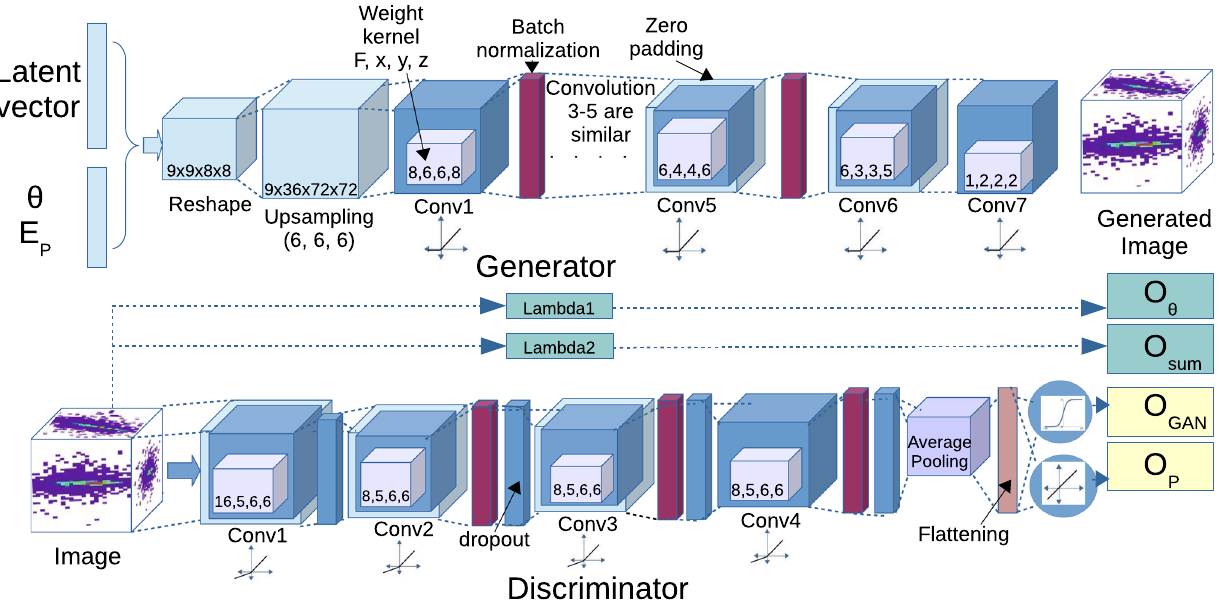
larger size of training data (400 k events) from each parti- cle type (electrons, photons, and neutral pions). The train and test losses are evaluated on the data divided in a ratio of nine to one. The first training step is run for 130 epochs (2 h per epoch on GTX 1080) while the second step is run for 30 epochs (4 h per epoch on GTX 1080). Finally, the best network is selected according to the minimum relative error for the sampling fraction ( SF ) related to the mapping of total deposited energy ( E sum ) to E P , on additional vali- dation data (20 k events are filtered around specific E P bins).